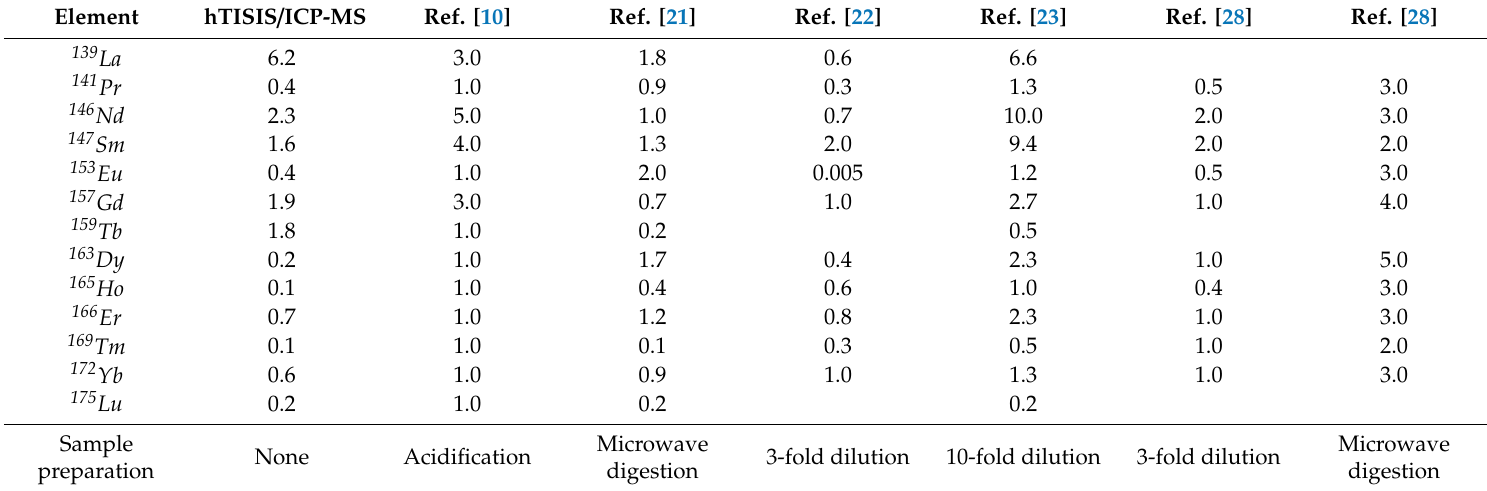
Table 1. Method detection limits of various inductively coupled plasma mass spectrometry (ICP-MS)-based analytical methods for rare earth elements (REEs) determination in wine samples (values in ng kg − 1